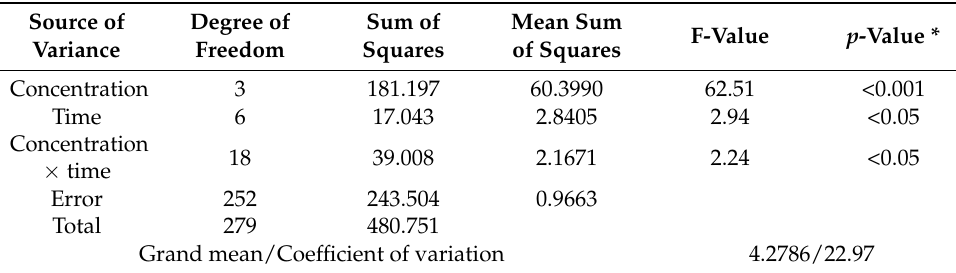
Table 2. Factorial ANOVA regarding the influence of Lecanicillium lecanii -derived partially purified protein on Bemisia tabaci fecundity rate (cf. Figure 2).